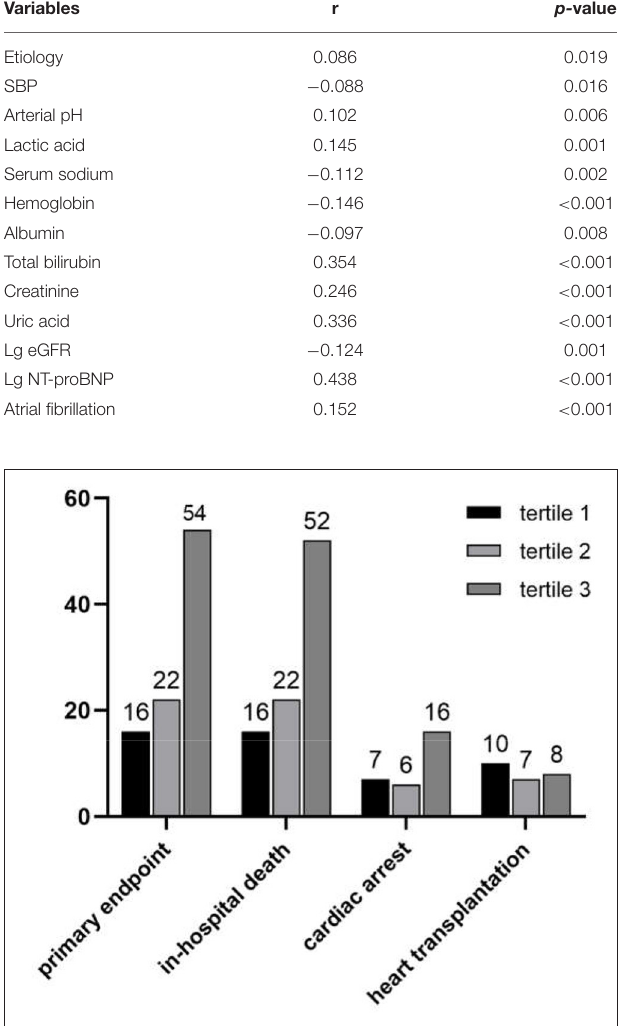
FIGURE 1 | Clinical outcomes based on big ET-1